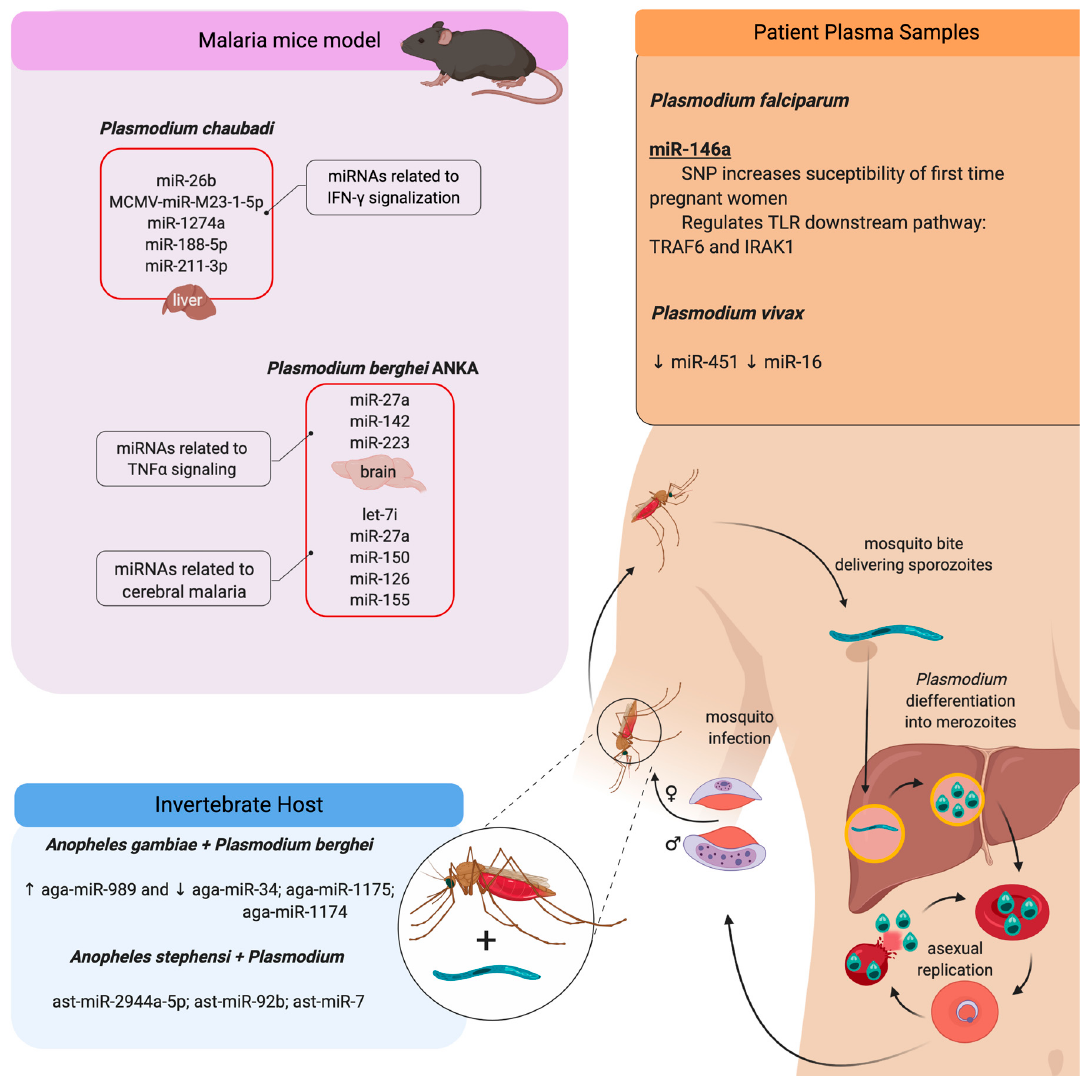
Figure 5. Plasmodium induces miRNA profile modifications during pathogen–host interaction. Human malaria infection begins with the bite of infected female mosquito Anopheles (invertebrate host), delivering sporozoite forms that migrate to the liver and differentiate into merozoites. These forms leave the liver and start the blood-stage asexual replication. In this stage, Plasmodium can differentiate into gametocytes, which can be ingested by the mosquito and develop the sexual phase of the life cycle. Afterward, the mosquito can infect another individual. The species P. falciparum and P. vivax are anthropophilic, infecting only humans; both of them can induce modifications in the miRNA profile in human plasma samples. Besides, mice infections with P. chaubadi and P. beghei have been used as malaria experimental models. In the murine infection, the parasite changes the circulating miRNA profile and it is seen in the same way in the liver of infected mice with P. chaubadi as it is seen in the brain of mice infected with P. berghei ANKA. Although, the invertebrate host presents modifications in the miRNA profile when infected with Plasmodium . The red boxes represent the upregulation of miRNAs related to these models. The arrows represent the upregulation ( ↑ ) or downregulation ( ↓ ) of